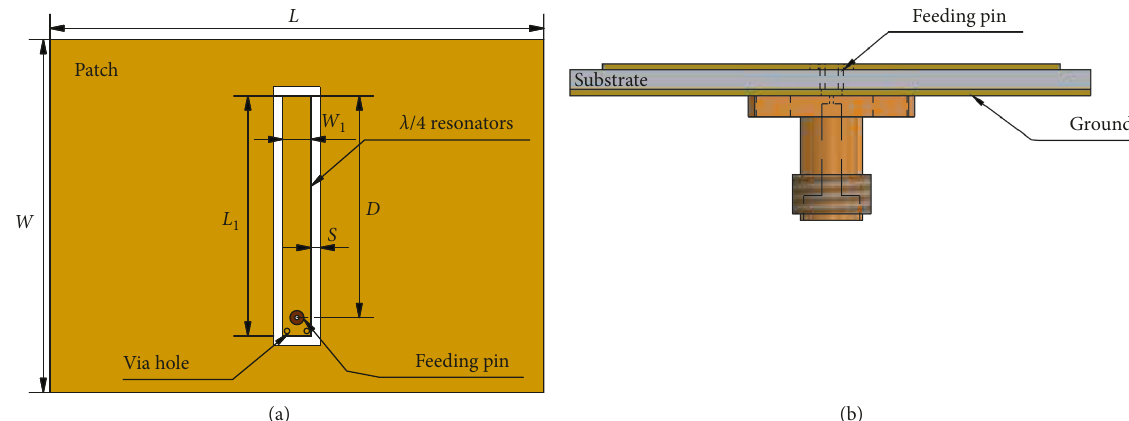
Figure 1: Physical layout of the proposed compact MA: (a) top view and (b) side view.